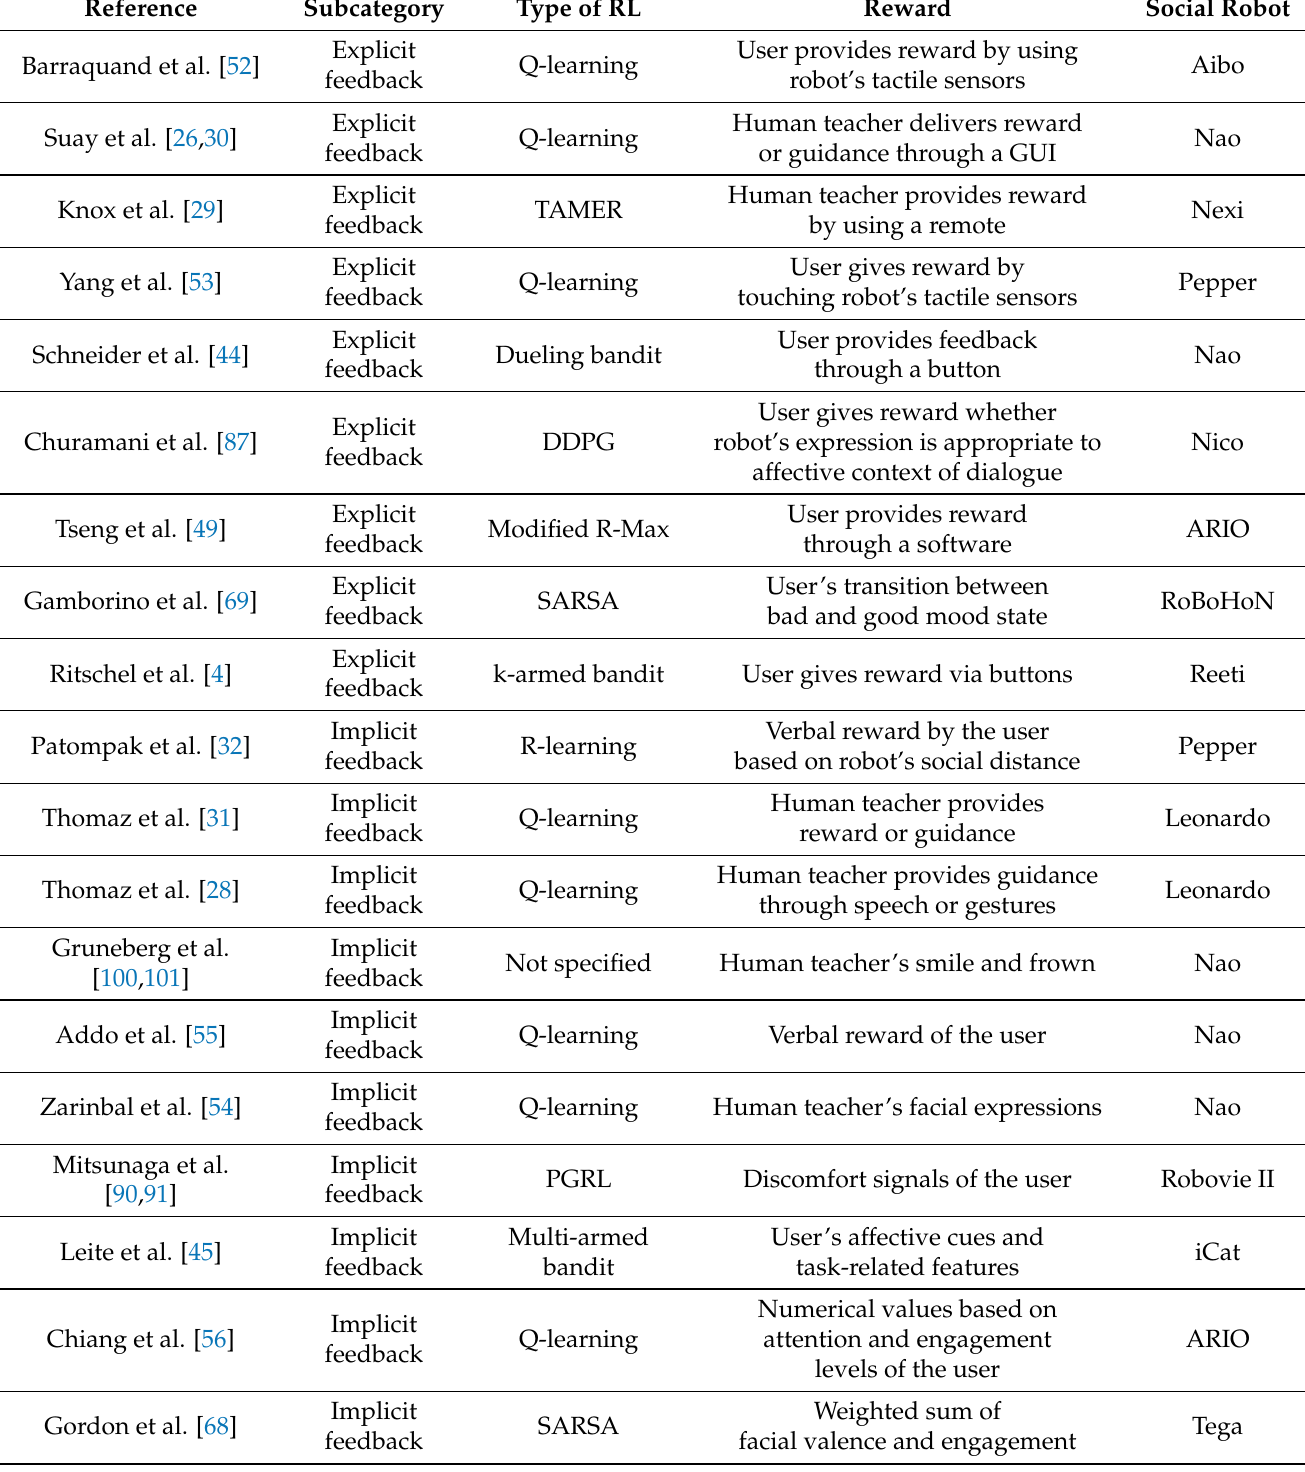
Table 1. Summary of Interactive Reinforcement Learning approaches in social